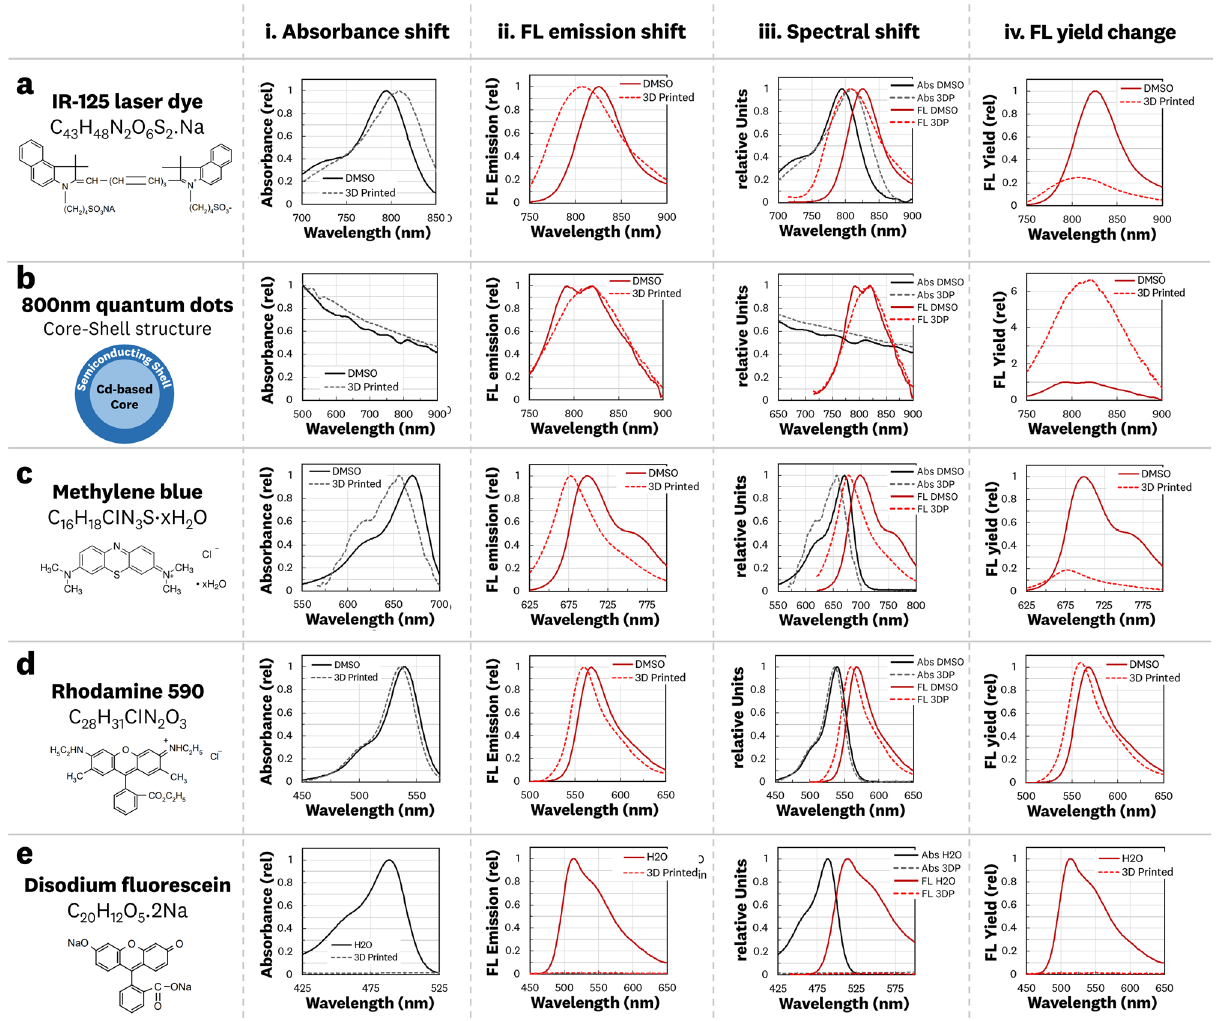
Figure 4. Spectral shifts ( i–iii ) and relative fluorescence yield change ( iv ) for 3D printed fluorescent materials compared to in-solvent fluorophores. ( a ) IR-125 laser dye shows significant spectra shift and broadening with a 0.24 × relative fluorescence yield. ( b ) 800 nm quantum dots show small shifts in spectra with a 6.7 × relative fluorescence yield. ( c ) Methylene blue shows a significant shift in spectra with a 0.18 × relative fluorescence yield. ( d ) Rhodamine 590 laser dye shows small spectra shifts and no significant change in the fluorescence yield. ( e ) Disodium fluorescein dye is inactivated in the 3D printing process, showing no detectable absorbance or emission